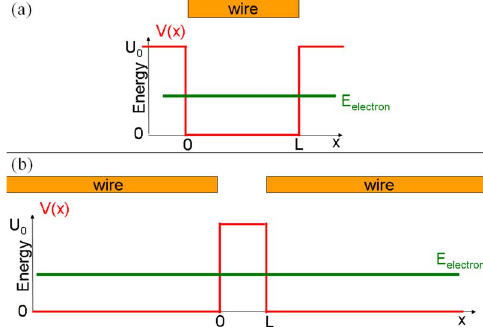
FIG. 4. (cid:1) Color (cid:2) Physical contexts for (cid:1) a (cid:2) a square well and (cid:1) b (cid:2) a square barrier. A square well with width L and height U 0 represents a wire with length L and work function U 0 . A square barrier with width L and height U 0 represents two long wires with work function U 0 separated by an air gap with length L